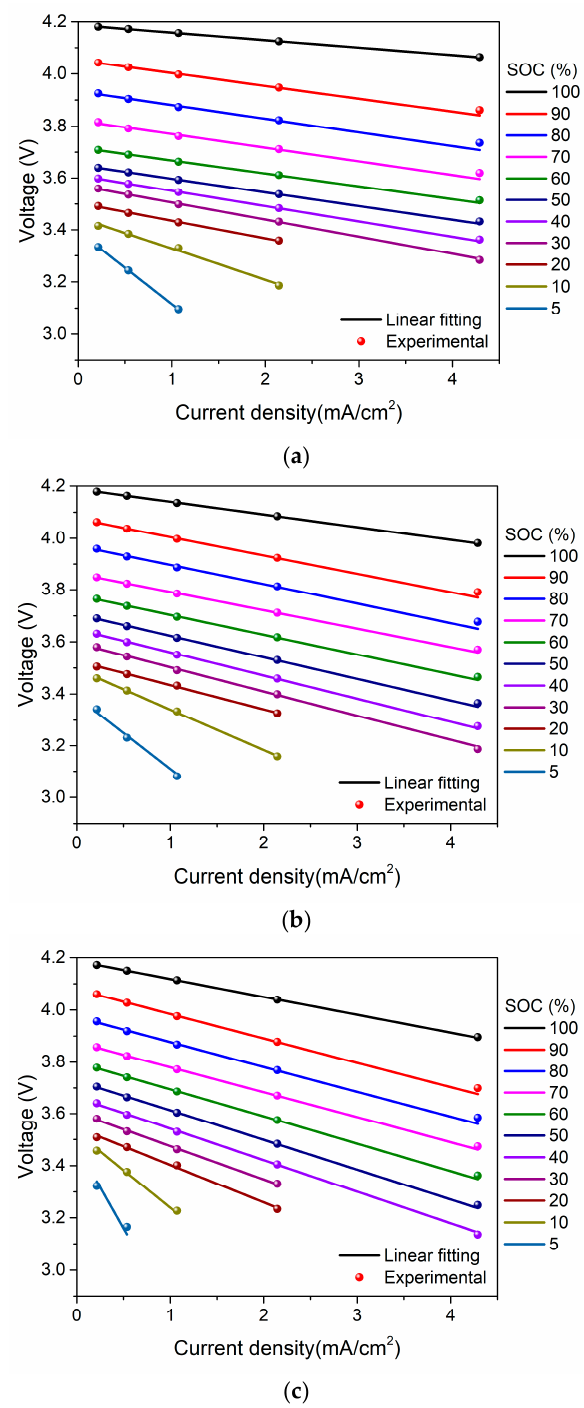
Figure 3. Cell voltage as a function of applied current density during discharge for the LIB cells with three different levels of the loss of cyclable lithium: ( a ) 0%; ( b ) 10%; and ( c ) 20%.